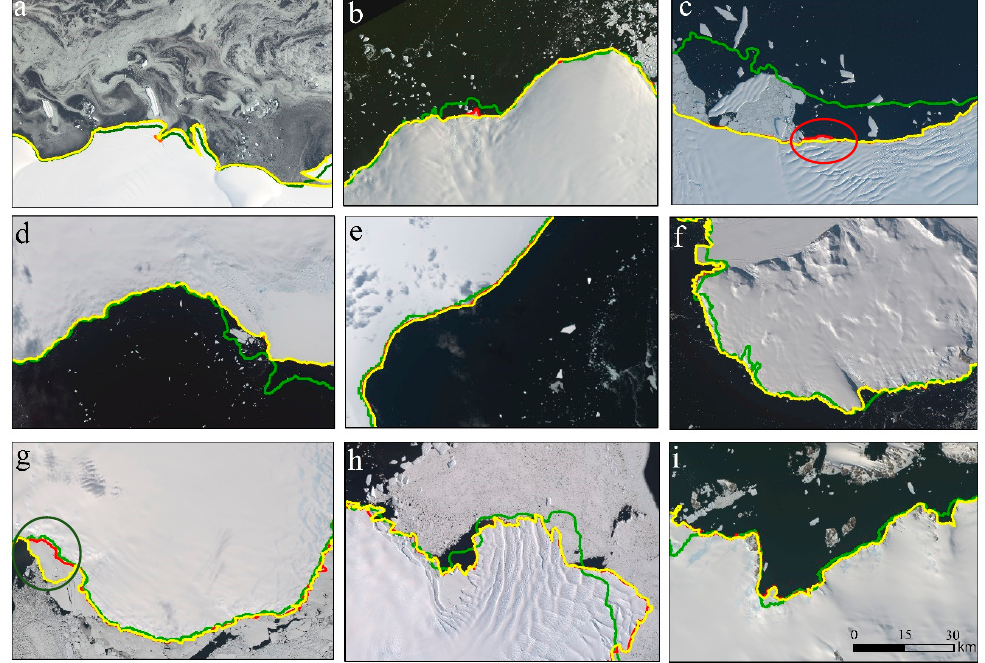
Figure 4. Coastline in 2010, derived from present automated method (yellow) compared to the manually extracted coastline (red) from same image, and MOA coastline (green) in 2009 for the nine areas. The nine areas shown here are marked by footprints of Landsat images labeled as areas (a-i) in Figure 3. Table 4. Deviation between the coastline in 2010 from our method and the manually extracted coastline for the nine areas (in meters). Areas (a-i) are marked in Figure